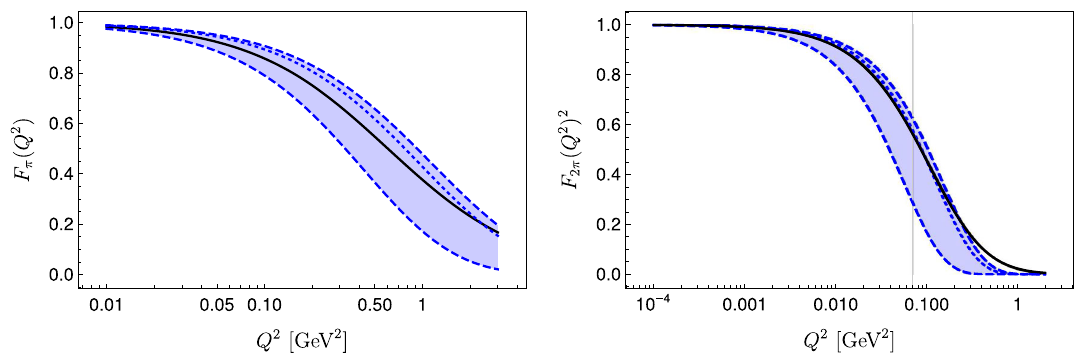
Fig. 10 Left panel: the pion form factor evaluated with the original model. The band stands for the results obtained by varying κ : 0 . 35 ≤ κ ≤ 0 . 59 GeV. Dotted lines represents the result for κ = 0 . 548 GeV. Right panel: same of the left panel for the quantity F 2 π ( Q 2 ) 2